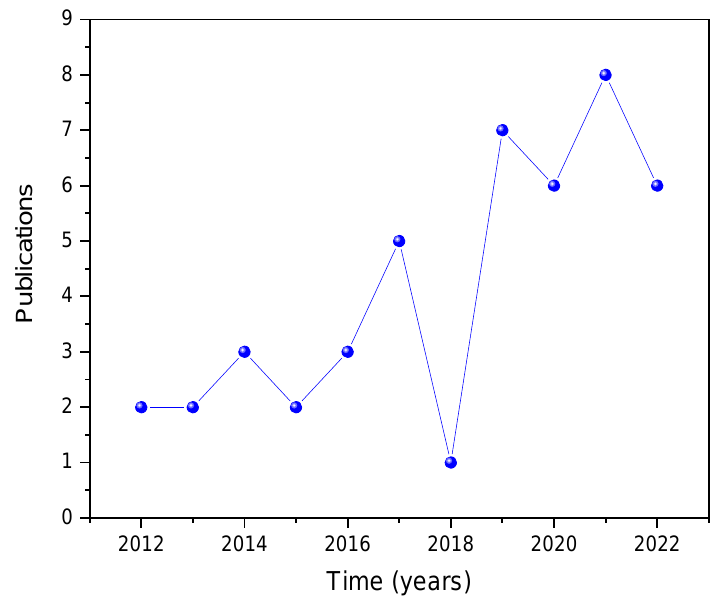
Figure 2. Comparison of graphs between the number of publications obtained in this mini-review and the Scopus database during the period 2012 to September 2022. Number of documents obtained in Scopus ( n = 82), with the search formula: “Biosensor” AND “Bacteria” AND “wastewater” .